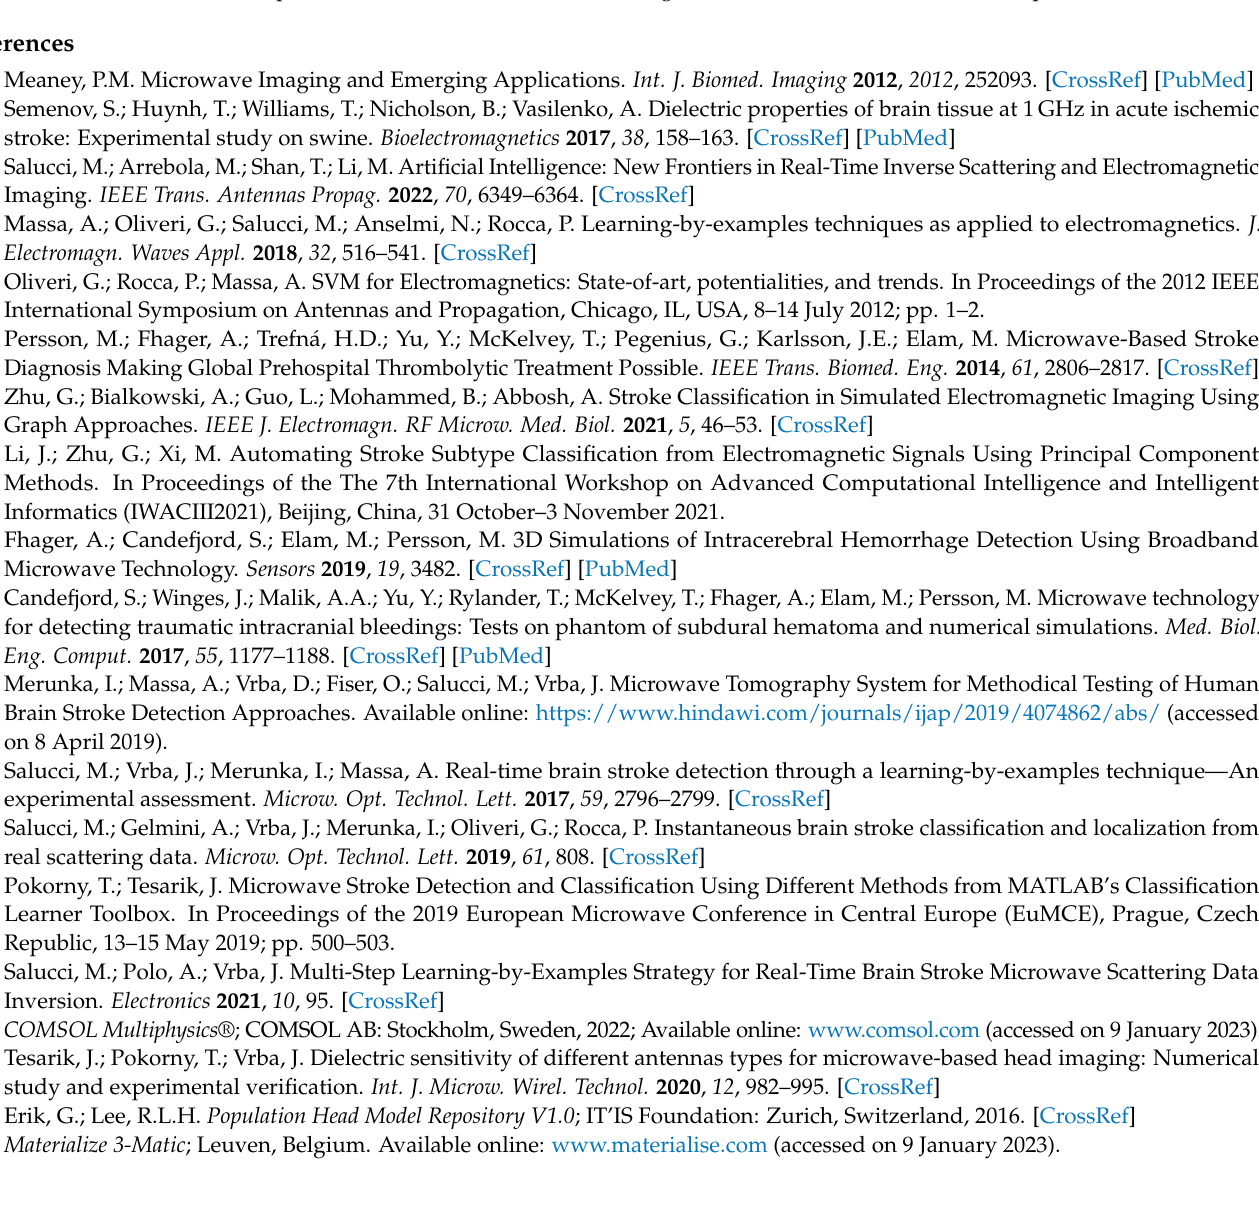
Figure A9. 3D numerical simulations. Calculated differences in S-parameters induced by the virtual presence of a 4 cm radius ( a ) hemorrhagic and ( b ) ischemic stroke located at position ( −2 0, 30).